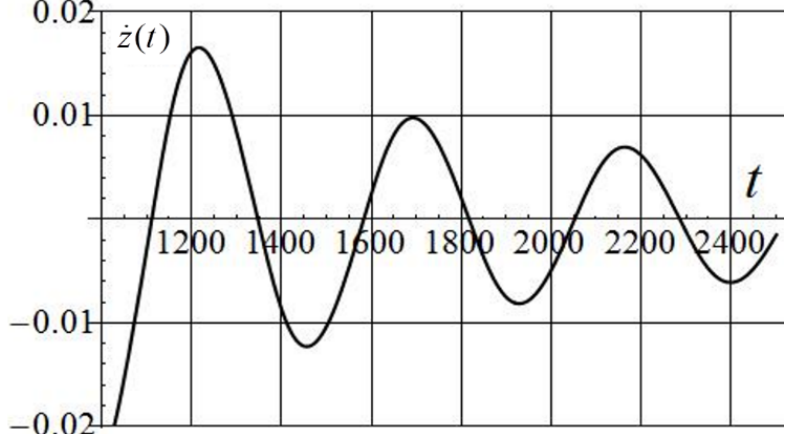
Figure 23. Illustration of the oscillatory character of the hanging mode: instantaneous position of the body relative to the point of hanging z = z 0 : steel cylinder l ∗ = l c = 2, η = 0.005, t ≥ 1000 s.